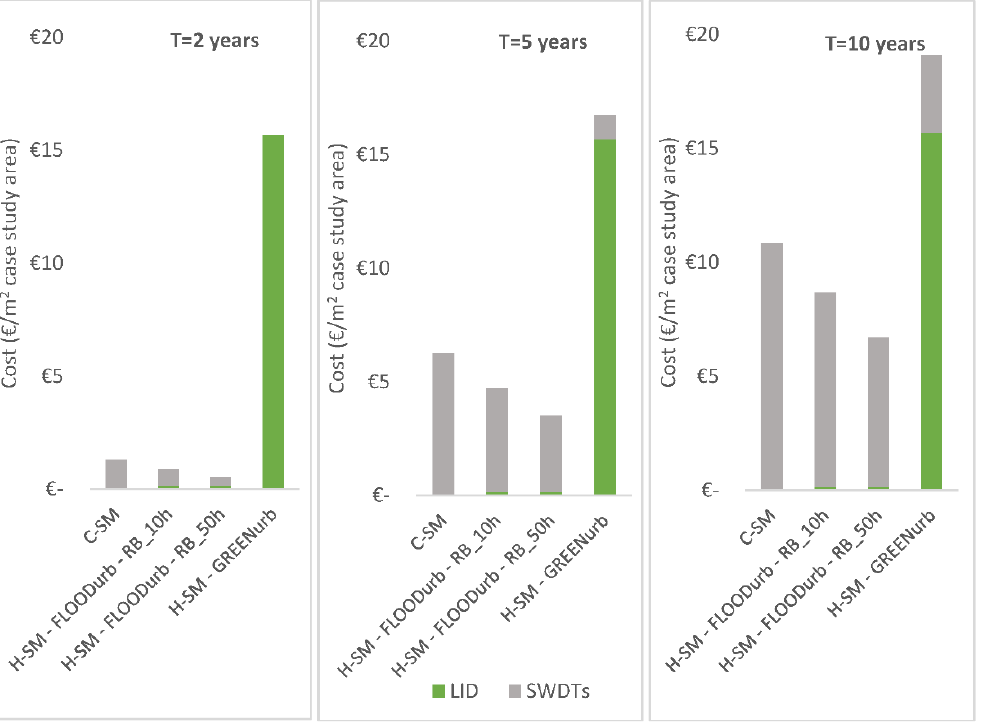
Figure 10. Cost of implementation of each investigated scenario under 2-year, 5-year, and 10-year return-period rainfalls and standardized as a function of the whole case study area (m 2 ).